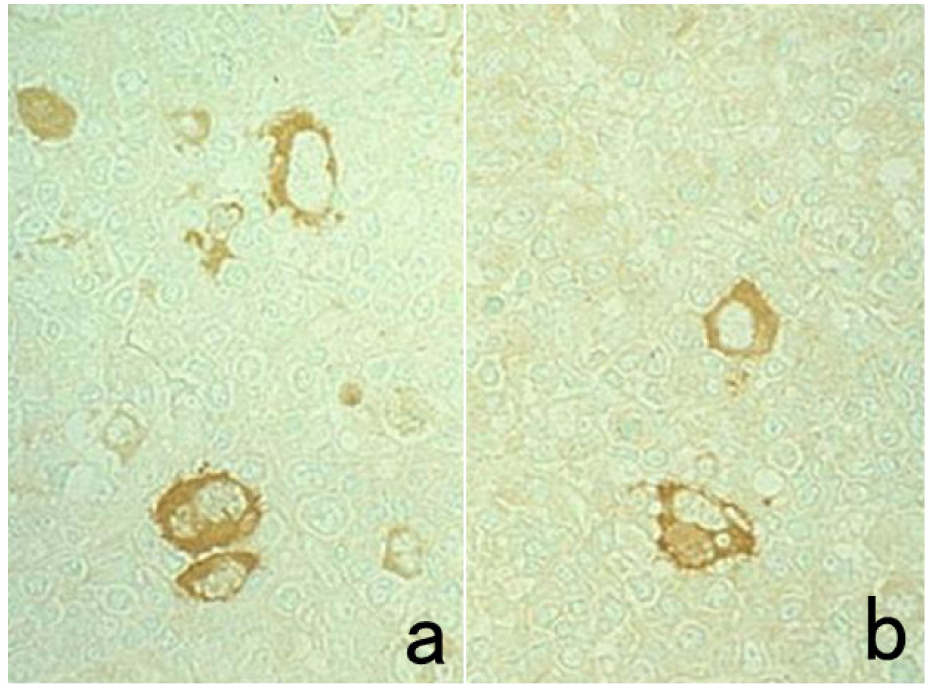
Figure 11. Diffusion artifact (I). Hodgkin’s lymphoma. The cytoplasm of Reed-Sternberg cells or Hodgkin’s cells is polyclonally positive for both kappa ( a ) and lambda ( b ) chains. The nuclei are negative. This represents an example of diffusion artifact of plasma proteins in FFPE preparations. The nuclei are counterstained with methyl green.